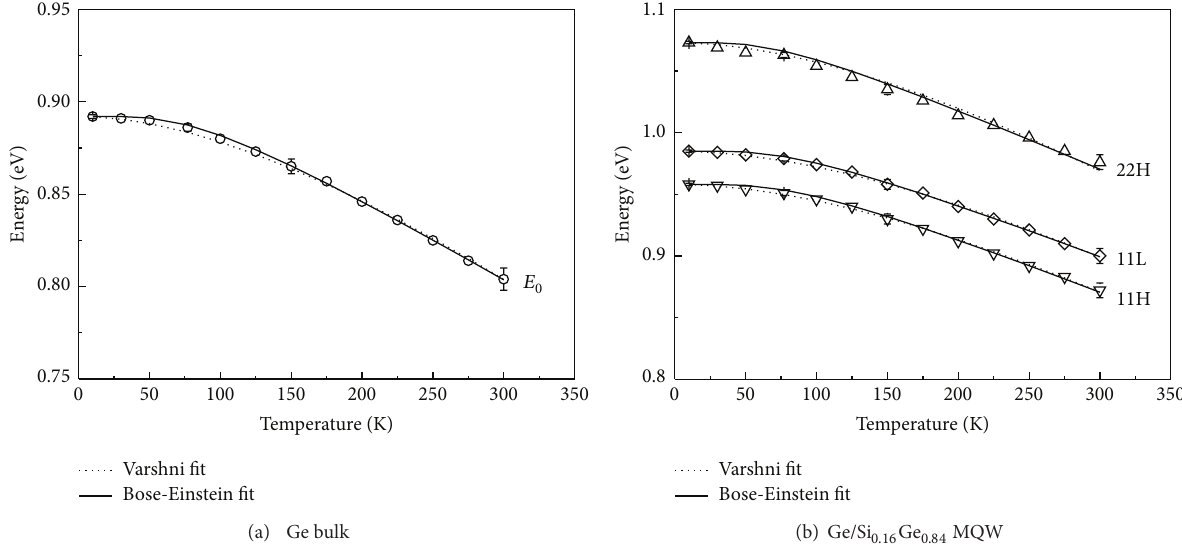
Figure 4: The temperature variations of various transition energies for (a) Ge bulk and (b) Ge/Si 0.16 Ge 0.84 MQW structure with representative error bars. The dashed curves are least-squares fits to the Varshni semiempirical expression. Solid curves are the least-squares fits to the Bose- Einstein